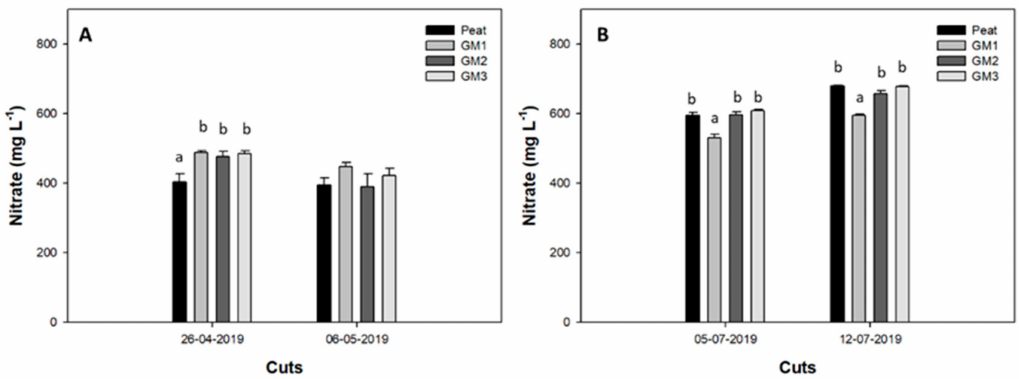
Figure 2. Nitrate content in the nutrient solution for both cuts in the spring ( A ) and summer ( B ) cycles using di ff erent growing media (peat, GM1, GM2, GM3). Values are the mean ± SD ( n = 9).